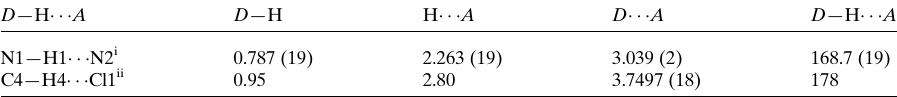
Table 1 Hydrogen-bond geometry (A˚ , (cid:3)